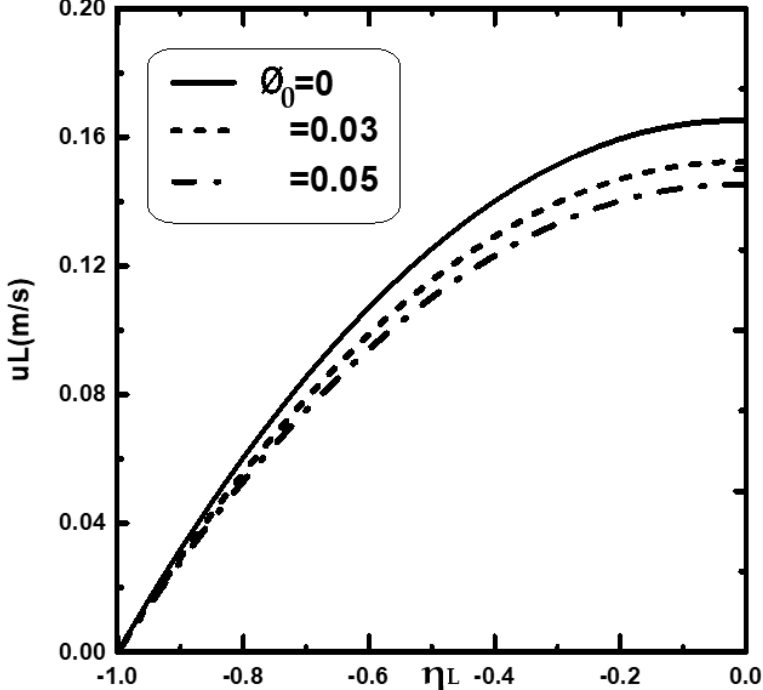
Figure 6. Effect of inlet nanoparticles volume fraction on the liquid velocity at the channel exit: T 0 =293.15 K, T 0L =293.15 K, T w =293.15 K, q 1 = − 1000 W/m 2 , c 0 =0.3, u 0 =1 m/s, m 0L =0.015 kg/m.s, H=1 m, d=0.015 m, p 0 =1 atm. exit: T 0 = 293.15 K, T 0L = 293.15 K, T w = 293.15 K, q 1 = − 1000 W/m 2 , c 0 = 0.3, u 0 = 1 m/s, m 0L = 0.015 kg/m.s, H = 1 m, d = 0.015 m, p 0 = 1